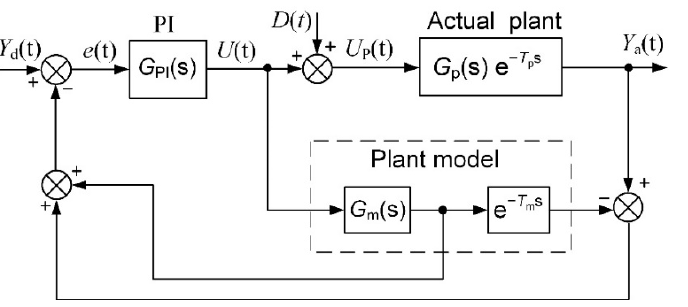
Figure 2. The block diagram of the control system based on the PI controller with the Smith predic- tor.